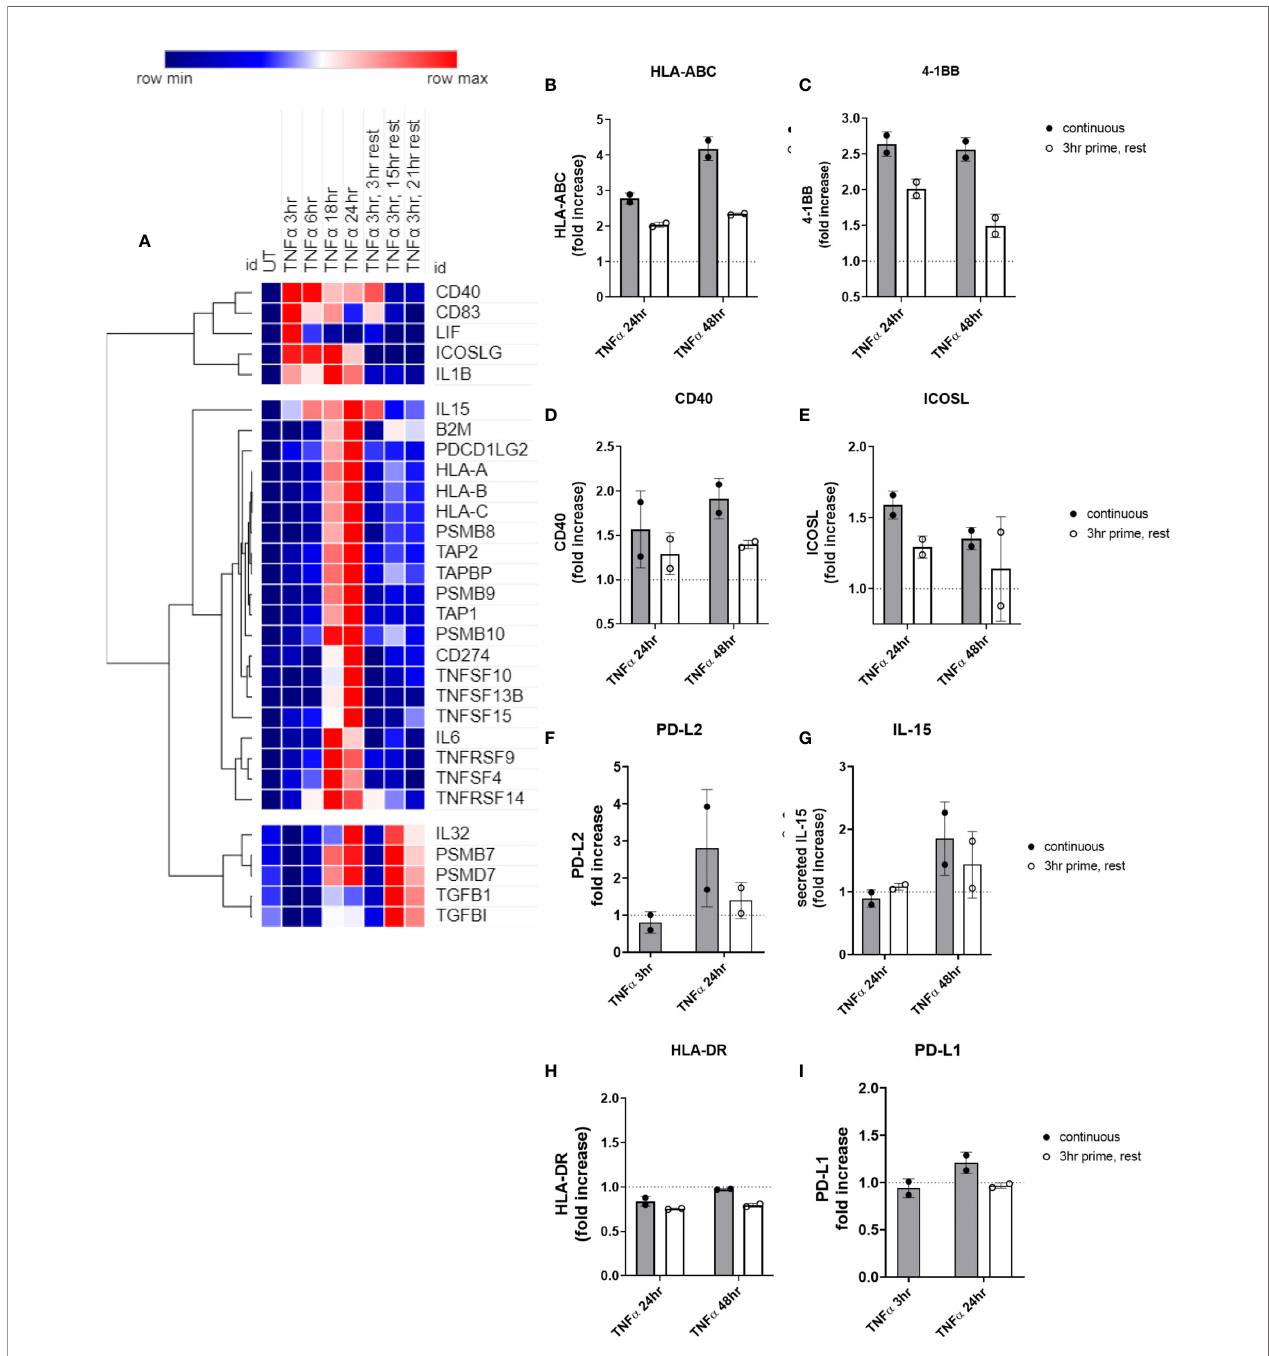
FIGURE 10 | Short priming with TNF a followed by withdrawal/rest in the absence of cytokine. (A) HMEC-1 endothelial cells were treated with TNF a (20ng/mL) for 3hr, 6hr, 18hr, or 24hr. In some conditions, medium was replaced after 3hr with medium without TNF a , and cells were allowed to rest for an additional 3hr, 15hr or 21hr. mRNA counts were measured by Nanostring and normalized to housekeeping genes and controls. Heat map shows relative gene expression over time, with normalization across genes/rows. Hierarchical clustering of rows by one minus Pearson correlation. (B-I) Primary human aortic endothelial cells were treated with TNF a (20ng/mL) for 3hr, 24hr or 48hr; or primed with TNF a for 3hr followed by an additional 21hr or 45hr without cytokine. Cell surface expression of (B) HLA-ABC, (C) 4-1BB, (D) ICOSL, (E) CD40, (F) PD-L2, (H) HLA-DR, and (I) PD-L1 was measured by fl ow cytometry (n=2). Secreted IL-15 was measured in the supernatants by ELISA (G) . Quantitated results are presented as average fold increase in MFI or cytokine of each molecule relative to untreated cells. Filled bars show values for the continuous presence of TNF a ; open bars show results at the end of the rest period after 3hr